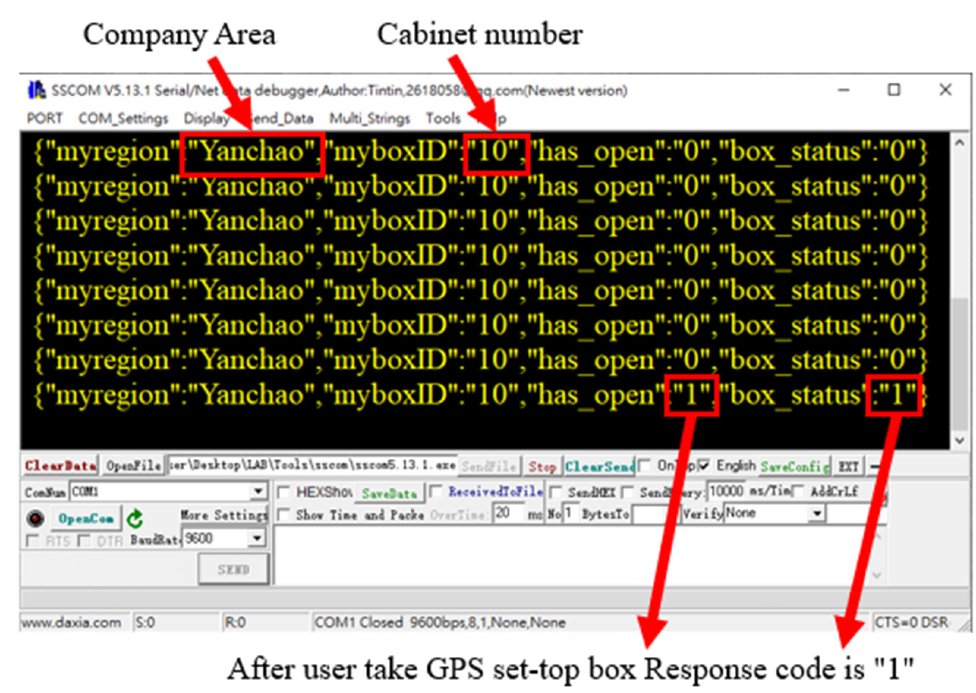
Figure 25. SSCOM read and return data diagram for using a vechicle.